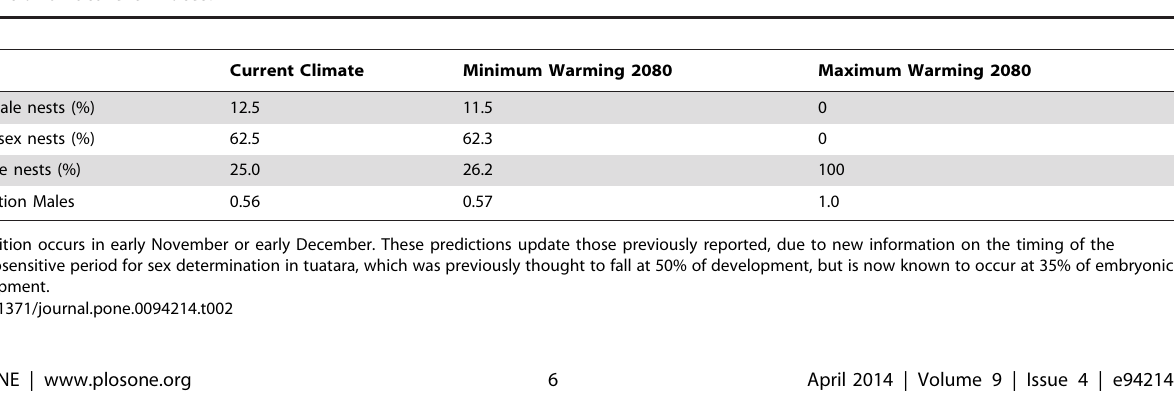
Table 2. Proportions of tuatara nest types and the aggregate hatchling sex ratio predicted at current nesting locations under current and future